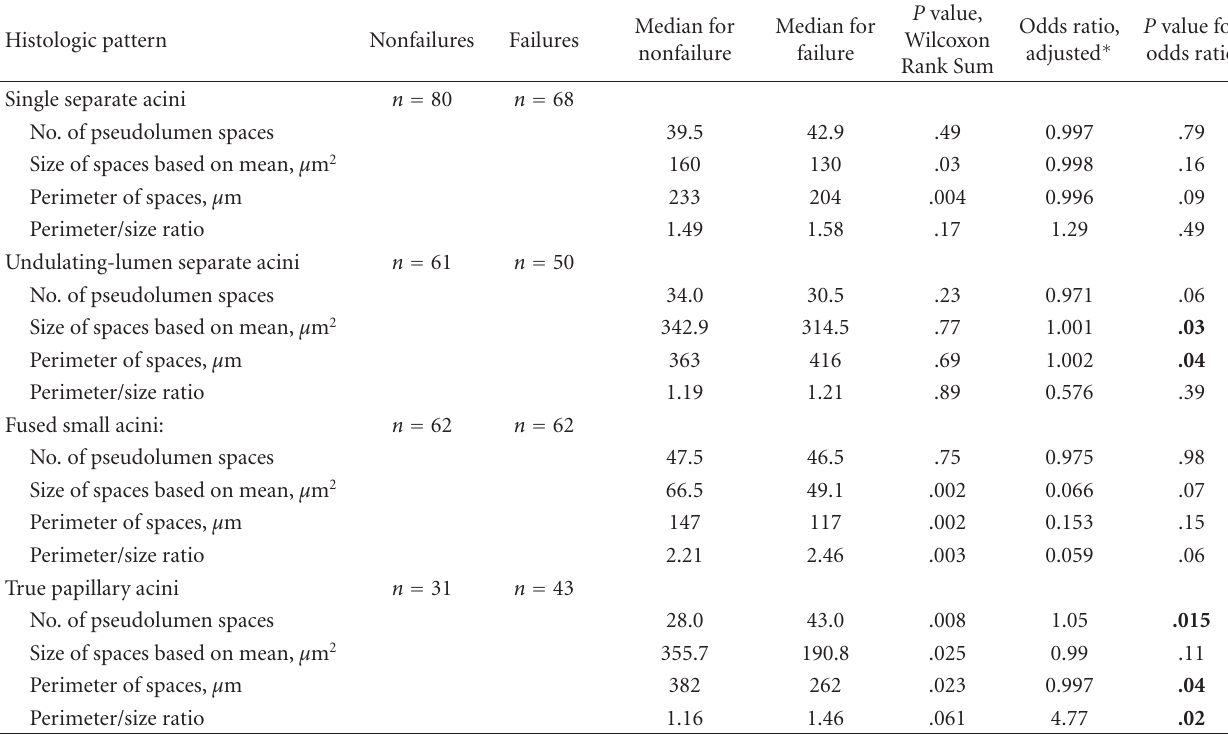
Table 1: Pseudolumen measurements according to pattern, other than cribriform.